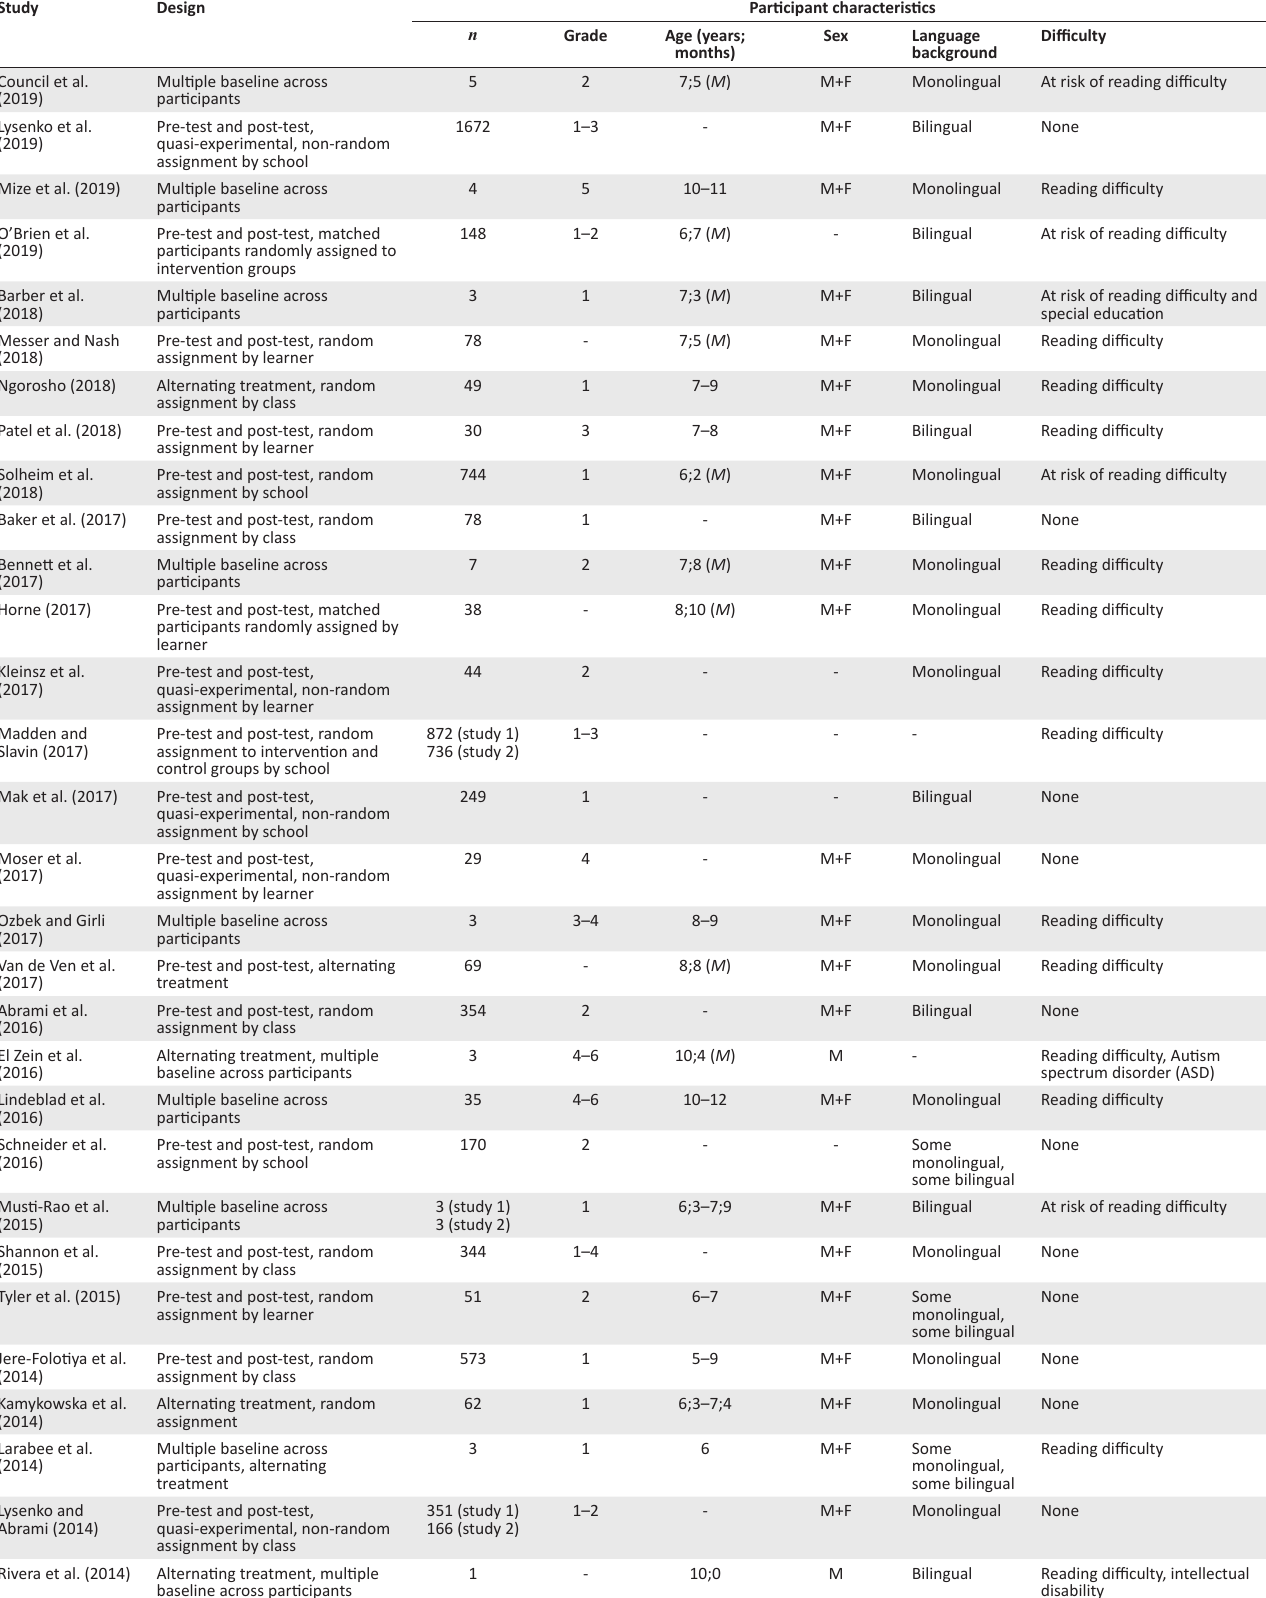
TABLE 1-A1: Design and participant characteristics of studies included in the information and communication technology-based reading intervention scoping review.